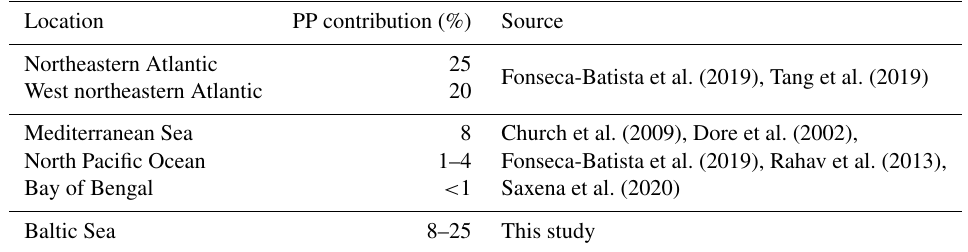
Table 1. Contribution of N 2 fixation to primary production (PP) in different ocean basins. Values represent mean values for the respective